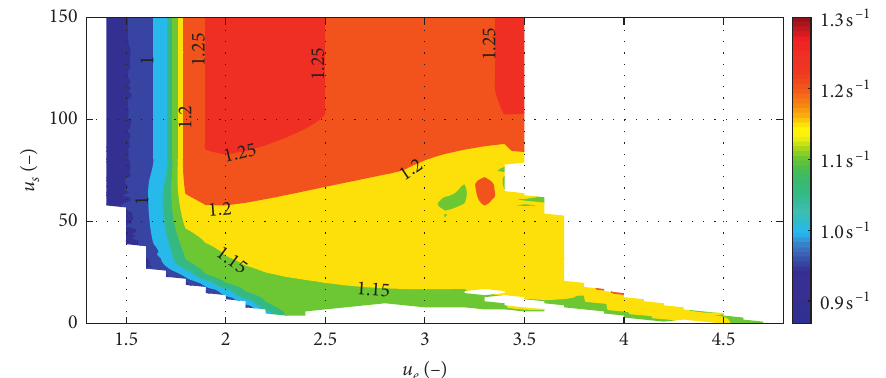
Figure 7: Step frequency as a function of the control parameters ( u